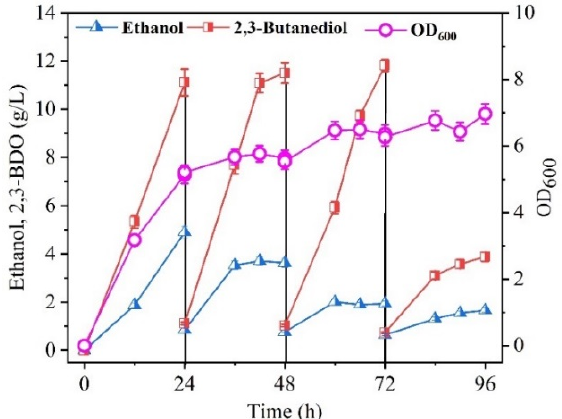
Figure 7. Kinetic curves of 2,3-BDO production in a membrane bioreactor with repeated-batch culture. Data are given as the mean ± SD, n = 2.